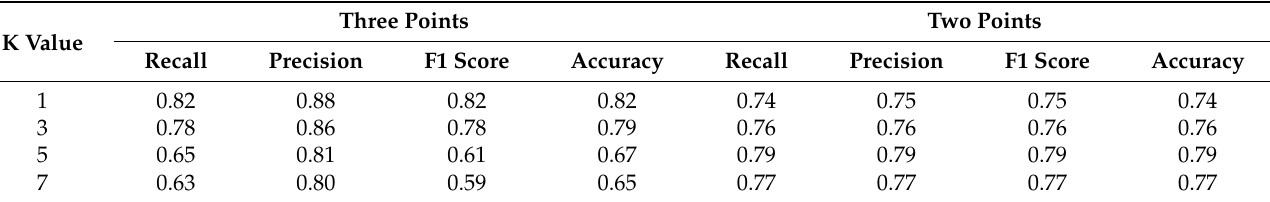
Table 3. Experiment with KNN